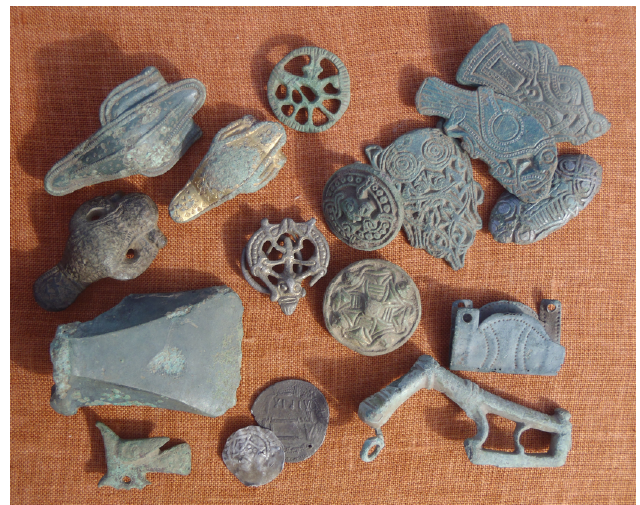
Figure 3: Selection of bronze artifacts (dress accessories and other implements) from different periods (ranging from the Bronze Age to the Medieval period) found on sites around Kerteminde in northeastern Funen, Denmark. The collection is representative of an average assemblage of so-called treasure trove , i.e., finds for which financial compensation is paid to the finder by the state (length of the fibula button, right: 6,2 cm). Photograph: Østfyns Museer, Kerteminde, Denmark.